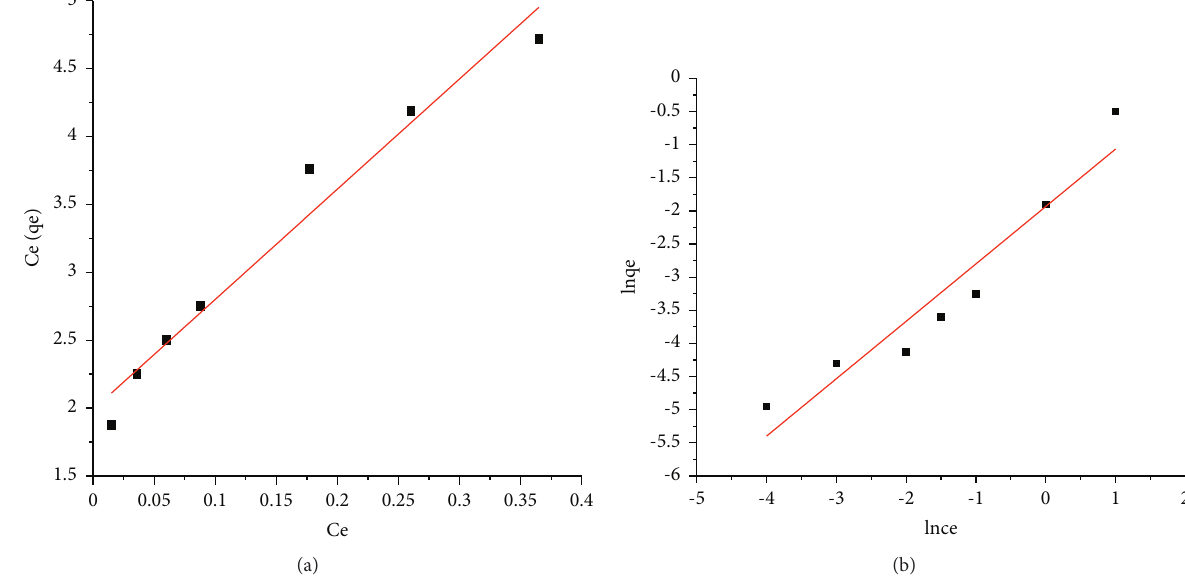
Figure 10: Adsorption isotherm of activated carbon of sorghum husk for adsorption of fluoride: (a) Langmuir isotherm; (b) Freundlich isotherm.